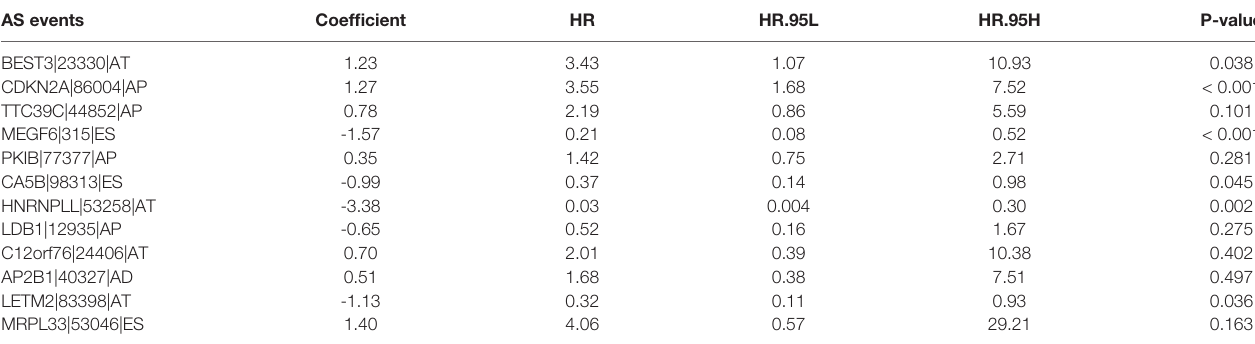
TABLE 2 | Twelve OS-relevant AS events in the LASSO prognostic model. AS events Coef fi cient HR HR.95L HR.95H P-value BEST3|23330|AT